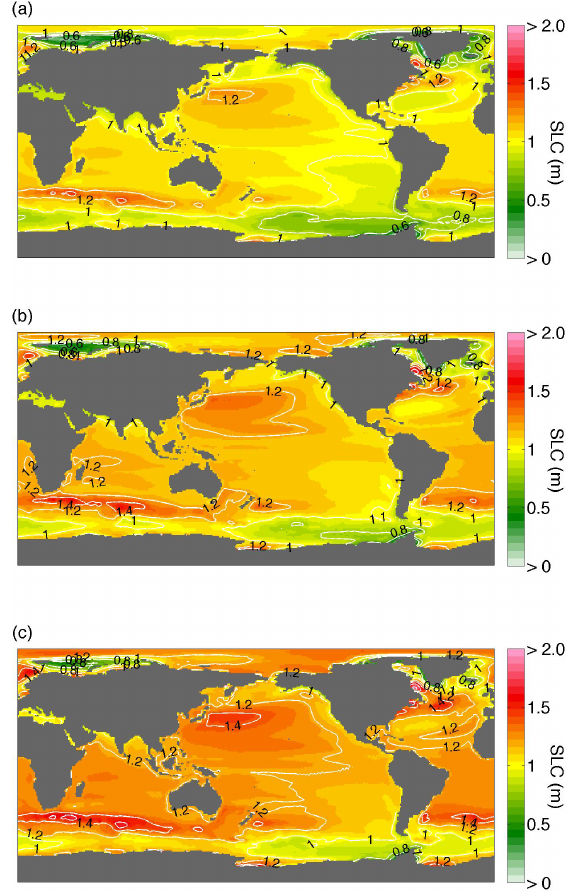
Figure A2. Sea level change (SLC) projections for high-end per- centiles by 2090 with symmetric IPCC-based distribution of dy- namical ice sheet mass loss combined with the regional SLC pro- jection of Slangen et al. (2014) following climate scenario